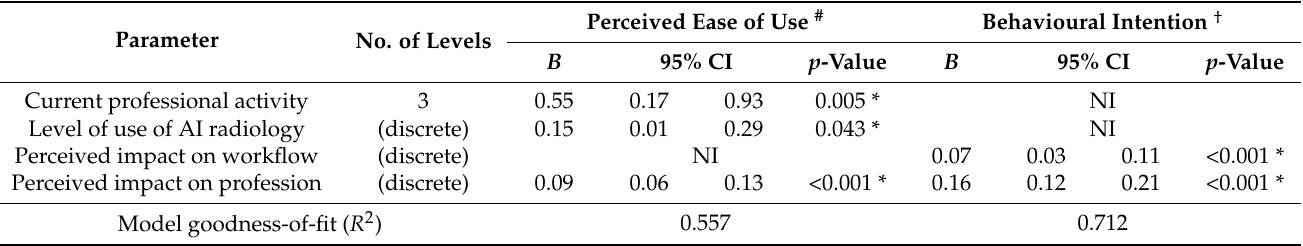
Table 6. Independent factors associated with perceived ease of use and behavioural intention to use AI (stepwise linear